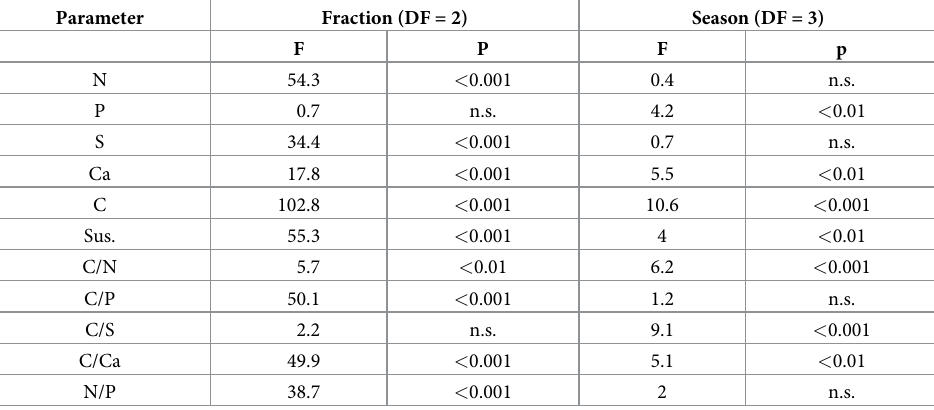
Table 1. The effects detritus fraction size (1000–250 μ m, 250–63 μ m, < 63 μ m) and sampling season (spring: Before the vegetation grow, summer: Maximum of vegetation grow, autumn: After leaf falling, winter: Snow cover) on nutrient content (C, N, P, Ca and S), detritus concentration, and C:N, C:P, C:Ca and C:S ratios deter- mined by GLM in detritus samples taken from outflowing spring water. Parameter Fraction (DF = 2) Season (DF = 3) F P F p N 54.3 < 0.001 0.4 n.s. P 0.7 n.s. 4.2 < 0.01 S 34.4 < 0.001 0.7 n.s. Ca 17.8 < 0.001 5.5 < 0.01 C 102.8 < 0.001 10.6 < 0.001 Sus. 55.3 < 0.001 4 < 0.01 C/N 5.7 < 0.01 6.2 < 0.001 C/P 50.1 < 0.001 1.2 n.s. C/S 2.2 n.s. 9.1 < 0.001 C/Ca 49.9 < 0.001 5.1 < 0.01 N/P 38.7 < 0.001 2